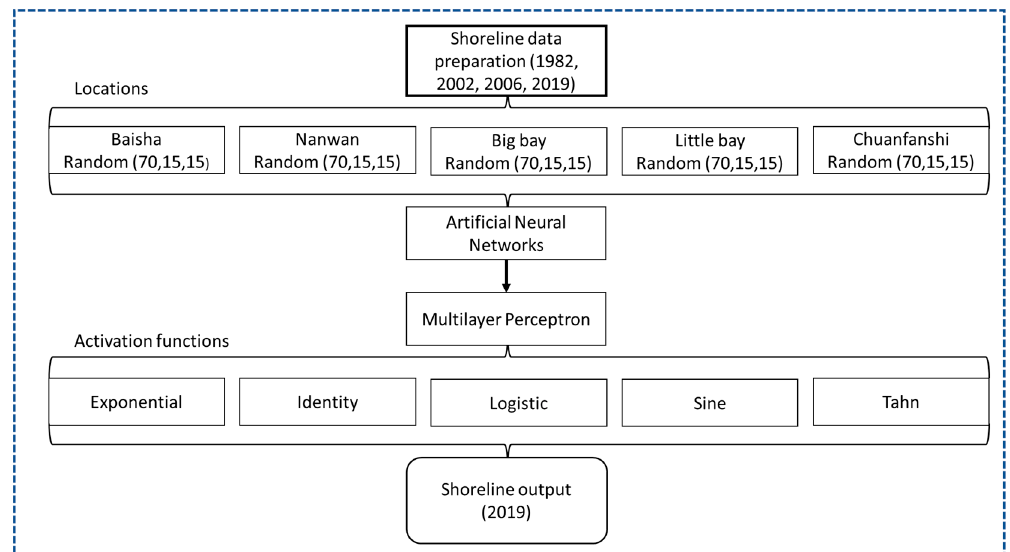
Figure 1. Location and images of the five beaches collected by the unmanned aerial vehicle (UAV).